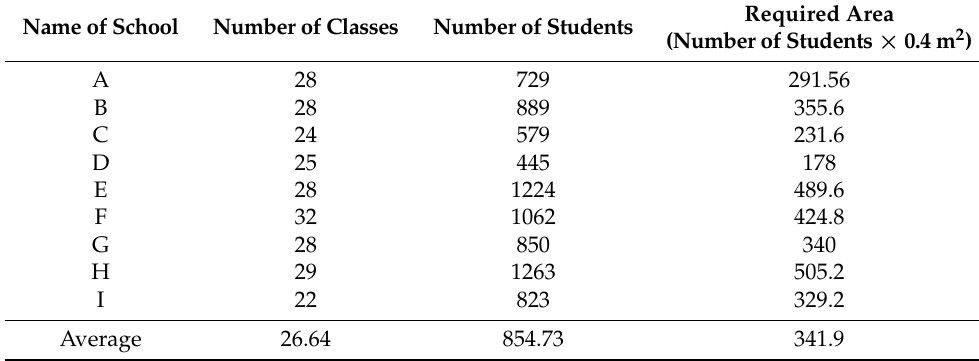
Table 2. Required area for the MPA-space of the elementary